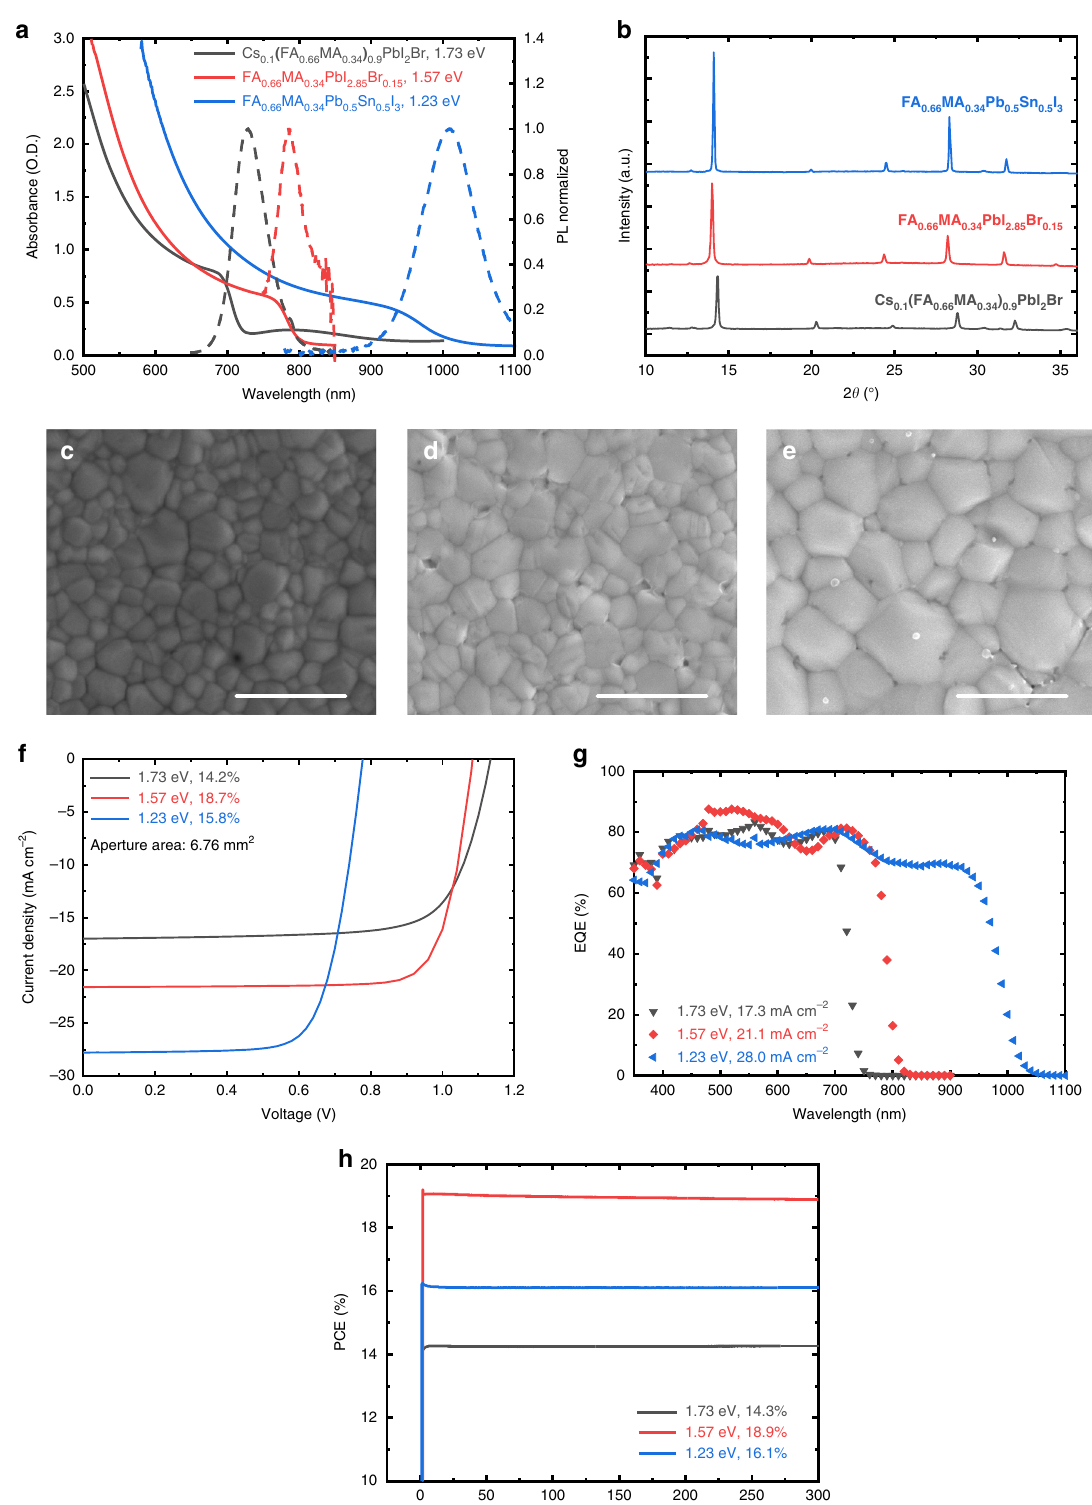
Fig. 1 Film characteristics and device performance of 1.73 eV, 1.57 eV, and 1.23 eV perovskites prepared by a two-step solution method. a UV-vis-NIR absorption spectra and steady-state photoluminescence. b XRD patterns of perovskite fi lms with different bandgaps. c – e Top-view SEM images of 1.73 eV, 1.57 eV, and 1.23 eV perovskite fi lms. Scale bars are 1 µ m. f Stabilized J – V curves (measured with 6.76 mm 2 aperture area). g EQE spectra. h Steady-state power output tracking for opaque PSCs with different bandgaps. Source data are provided as a Source Data fi